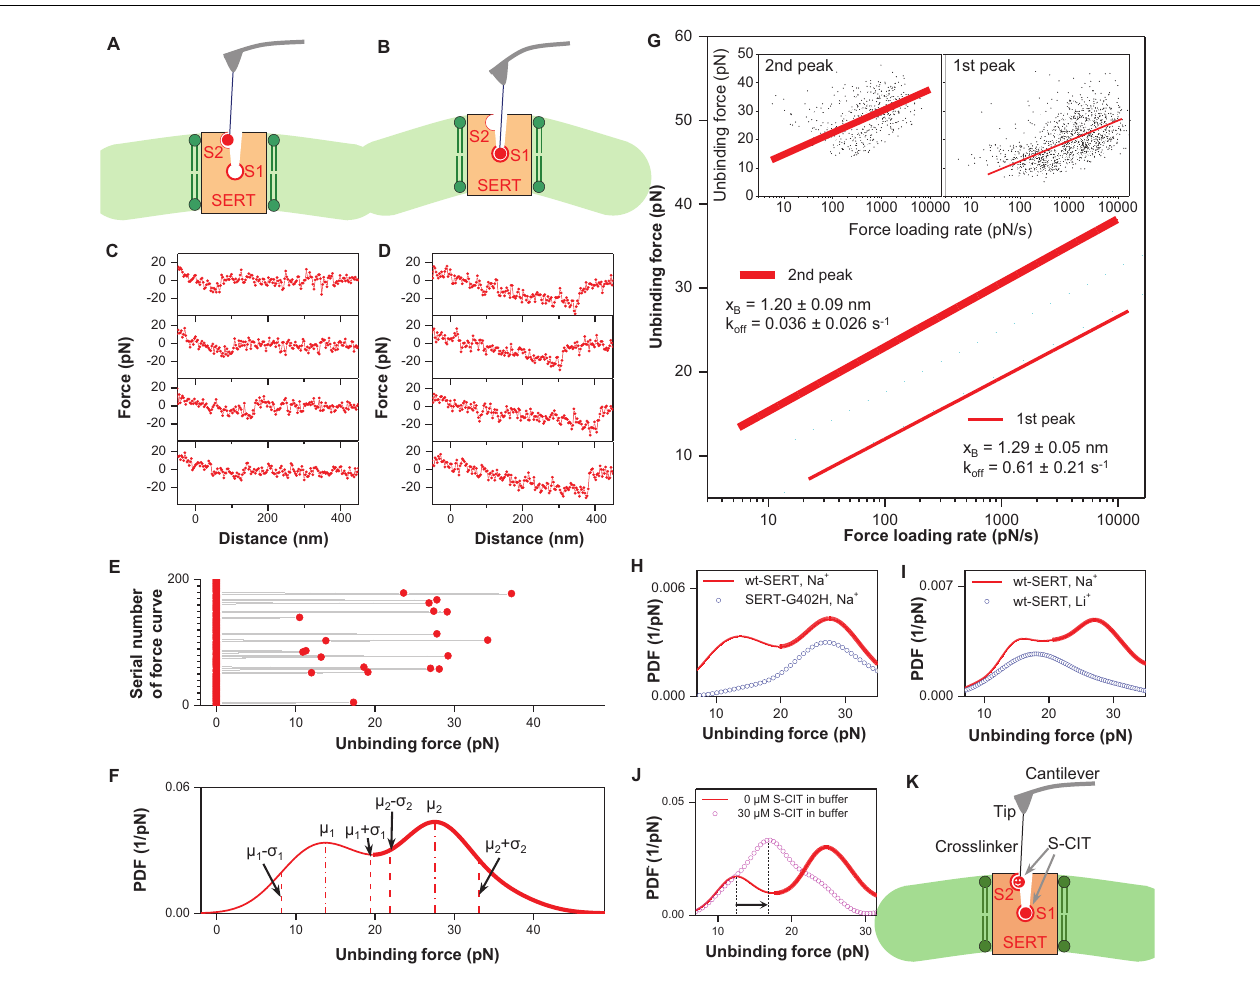
FIGURE 2 | (A–E) Two populations of interaction forces displaying different force strength were observed from repeated force measurements (Zhu et al., 2015). Four representative curves of each population are shown in (C) and (D) , respectively, which arose from two different binding sites (A,B) in SERT. Larger forces result in longer unbinding lengths that mainly arise from deformation of the elastic cell membrane. From repeatedly recorded data (E) , an experimental probability density function (PDF) of the unbinding forces was generated (F) . For analysis of each individual binding site, the unbinding events were separated by using the range µ – σ to µ + σ , where µ is the center of the peak and σ is the standard deviation of the Gaussian fitting (Zhu et al., 2018). (G) The data points of unbinding forces for the S1 (2nd peak) and S2 (1st peak) binding site, respectively, were plotted against the logarithm of the force loading rate (insets). They were fitted with Evans’ single energy barrier model, from which the kinetic off rate k off and the width of the energy barrier x B were extracted. (H) Force measurements on mutant SERT-G402H (point mutation in vestibular S2 site) show only a single peak, which corresponds to the second peak for wt SERT. This indicates that the S2 binding site is not accessible with the mutation, but the S1 site remains intact. (I) Force measurements on wt SERT in buffer without Na + (Li + buffer) display only a single peak as well, which corresponds to the first peak for wt SERT in Na + buffer. This indicates that the S1 site is completely inactivated in Li + buffer, but the S2 binding site is still active. (J) 0.03 mM S-CIT in solution blocked the S1 site (the second peak in the force PDF). The S2 site was slightly strengthened, as shown by the shift of the first peak in force PDF to the right, indicating a positive allosteric effect (K) . (A–I) are reproduced from Zhu et al. (2015, 2018) with